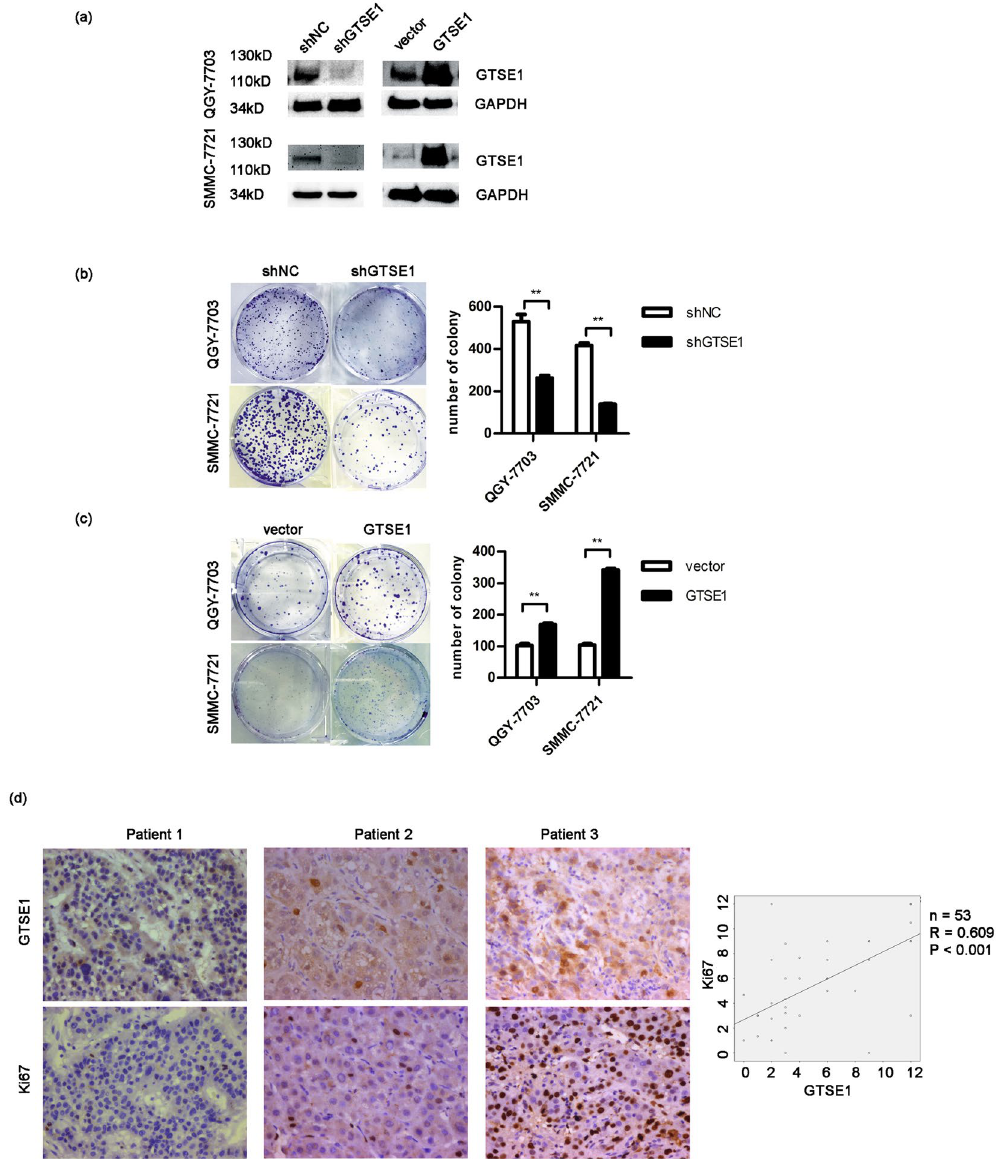
Figure 2. GTSE1 enhances cancer progression in HCC. ( a ) Expression of GTSE1 in QGY-7703 and SMMC- 7721 cells stably expressing shGTSE1 or GTSE1 and controls. Original data are presented in Supplementary Fig. 3. ( b ) Colony formation assays using QGY-7703 and SMMC-7721 cells transfected with GTSE1-shRNA (shGTSE1) or scramble (shNC). ( c ) Colony formation assays using QGY-7703 and SMMC-7721 cells transfected with GTSE1-GFP (GTSE1) or control-GFP (vector). ( d ) Representative expression levels of GTSE1 and Ki67 in HCC tissues by immunohistochemistry. Bivariate correlation analysis was employed to analyse the correlation between GTSE1 and